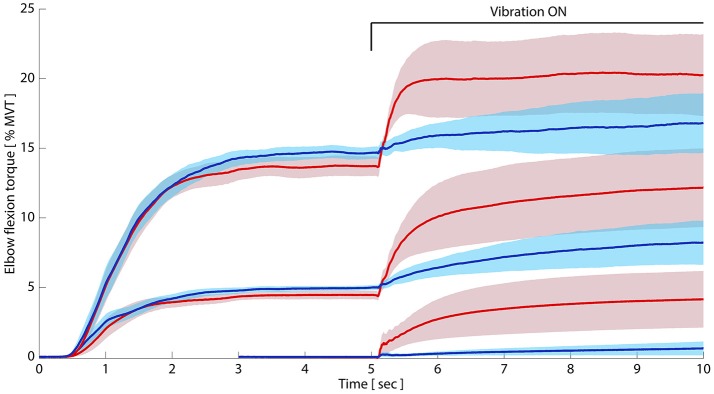
Paretic limb tonic vibration reflexes remain exaggerated despite preactivation. Paretic and non-paretic elbow flexors were preactivated to 5 and 15% of MVT, respectively, before vibration began. Despite matching preactivation levels between limbs, group average (N = 10) paretic TVRs (pink) significantly exceeded non-paretic TVRs (blue). Bottom paretic and non-paretic traces are TVR responses in relaxed elbow flexors, with data adapted with permission from McPherson et al. (2018). Shaded region around each TVR curve represents ± 95% confidence interval. Y-axis: elbow flexion torque as percent of maximum; x-axis: time in seconds. Permission to adapt images from McPherson et al. (2008) is afforded by the American Physiological Society under original author rights.